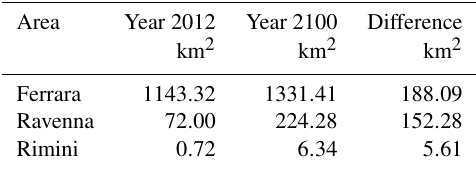
Table 6. Detail of the future areas below sea level compared to year